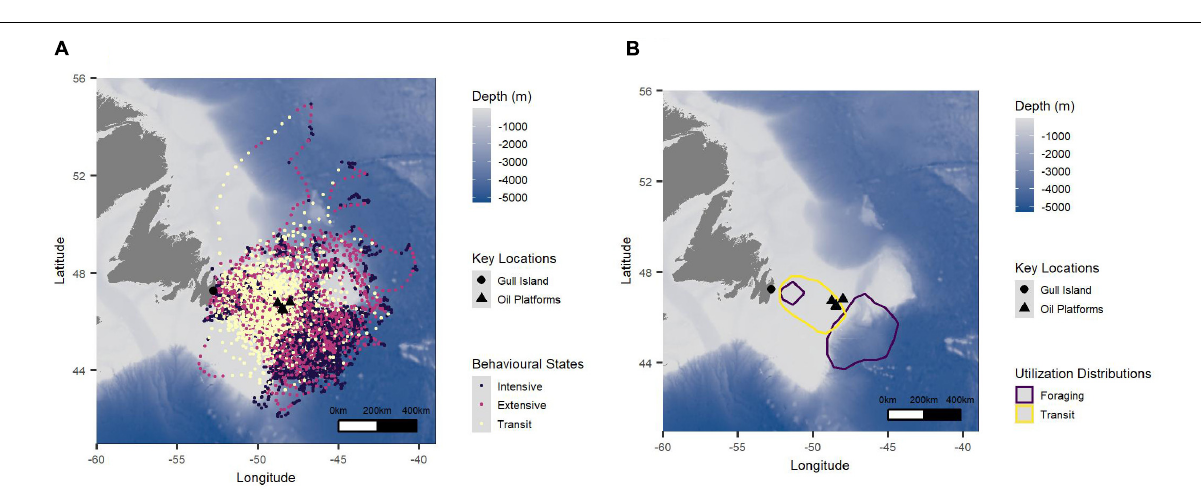
FIGURE 4 | (A) All tracking points colored by behavior (intensive search: black, extensive search: pink, transit: yellow) and (B) 50% utilization distributions of transiting (yellow) and foraging (intensive and extensive states combined; purple) locations for Leach’s Storm-Petrels in the study sample from Gull Island, Witless Bay, Newfoudland and Labrador, Canada from 2016 to 2021. The large black triangles represent the oil platforms, and the large black circle represents Gull Island. The bathymetry is represented where darker blue indicates deeper water. Data from all years and breeding phases are included in these